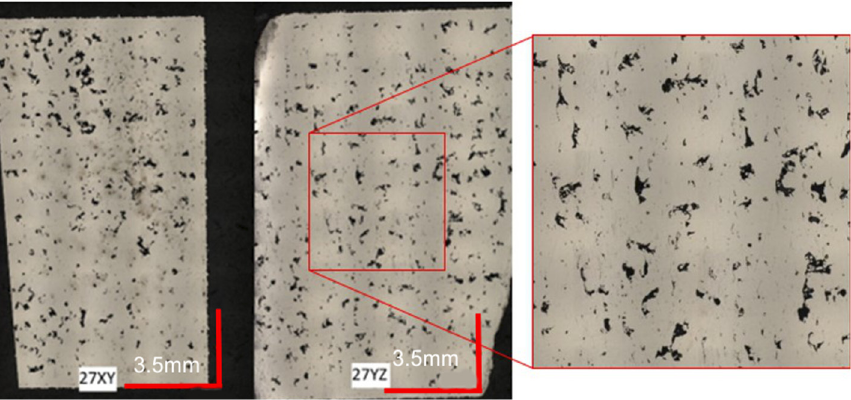
Figure 9. Image of the sample structure produced using 27th parameter group. On the left is the melt plane of a single layer. On the right is a cross-section through all layers.